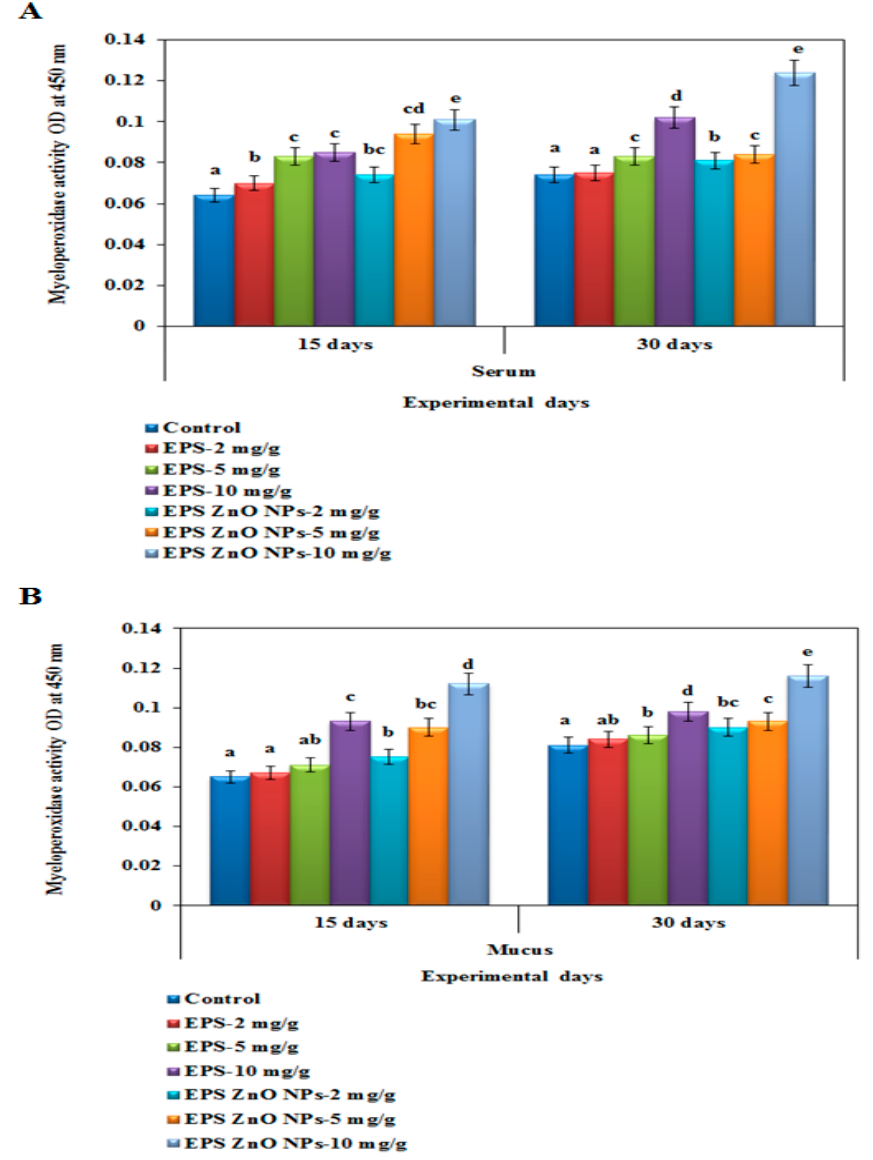
Figure 1. Myeloperoxidase activity of O. mossambicus fed with EPS and EPS-ZnO NPs: ( A ) serum and ( B ) mucus. T-bars indicate three replicates of mean ± SD, and different letters correspond to the statistical difference between treated groups.